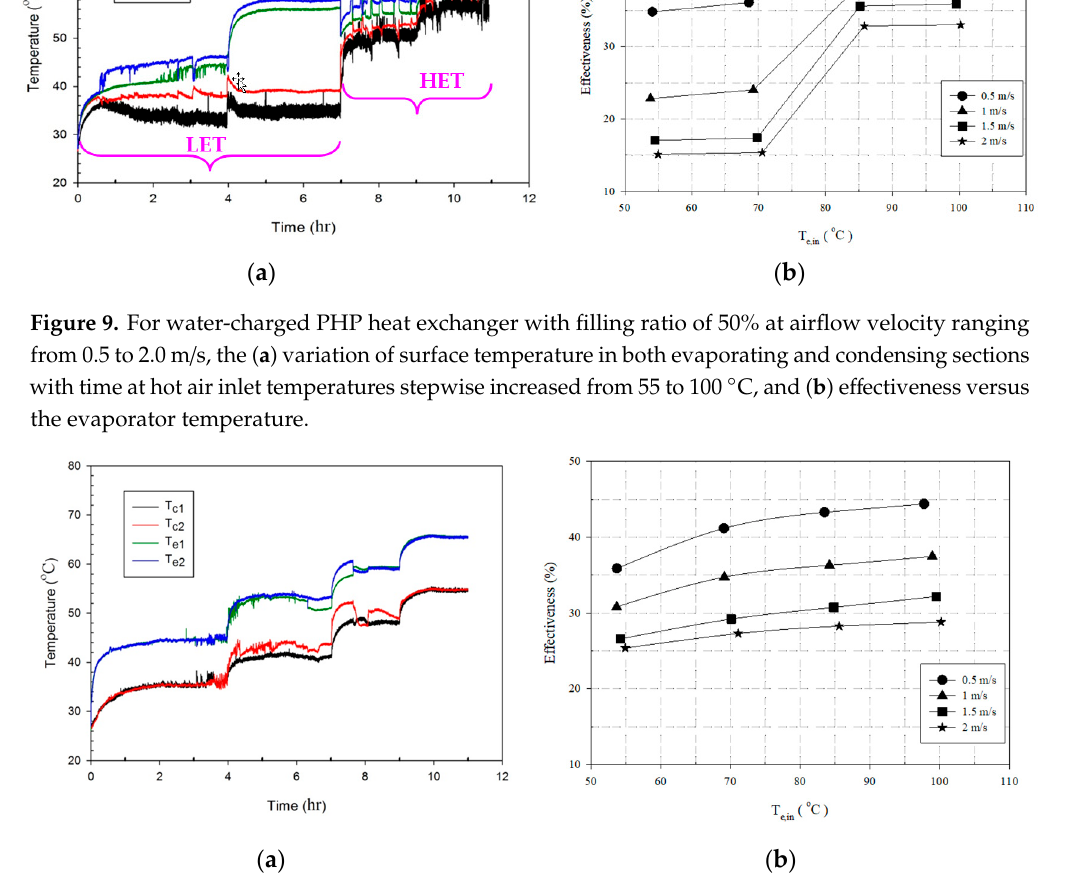
Figure 10. For HFE-7000-charged PHP heat exchanger with filling ratio of 50% at airflow velocity ranging from 0.5 to 2.0 m/s, the ( a ) variation of surface temperature in both evaporating section and condensing section of the with time at hot air inlet temperatures stepwise increased from 55 to 100 °C, and ( b ) effectiveness versus the evaporator temperature.